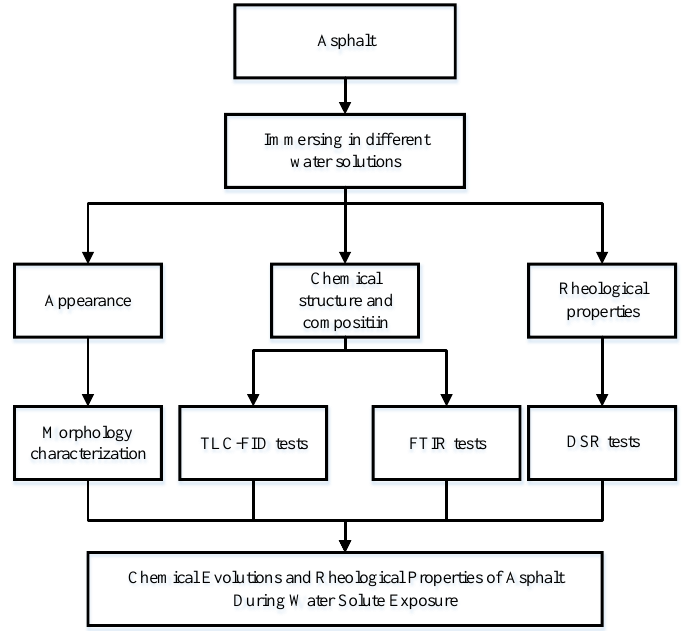
Figure 1. Experimental program plan.